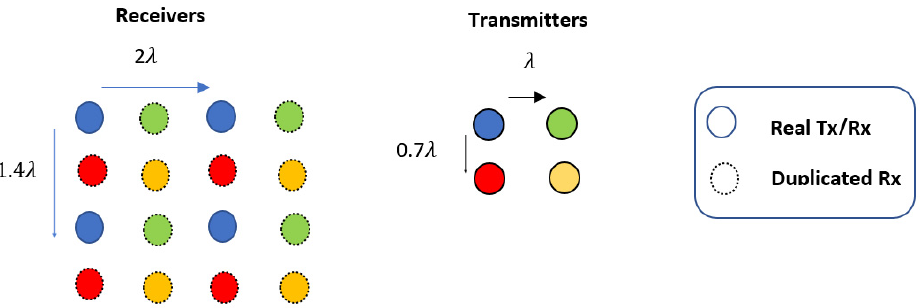
Figure 18. Separated radar with MIMO DBF virtual array duplication.